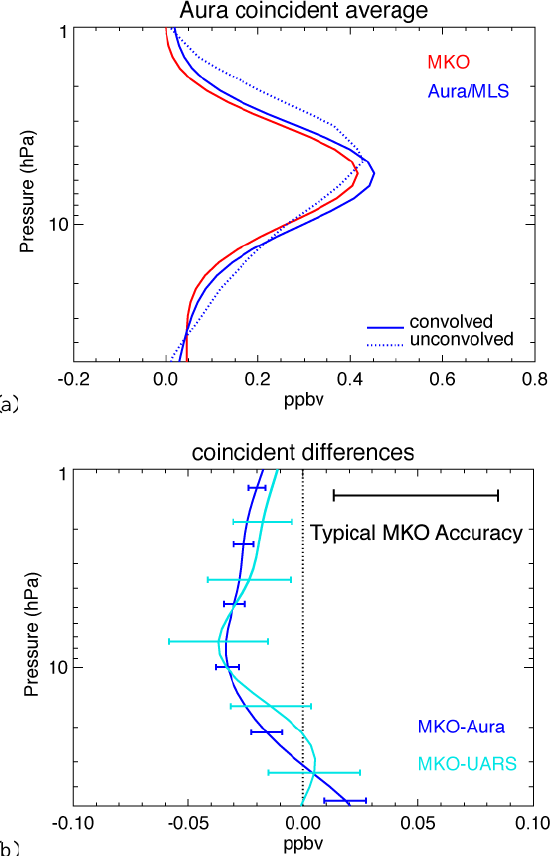
Fig. 6. Comparison of revised Mauna Kea ClO to that from Aura and UARS MLS.